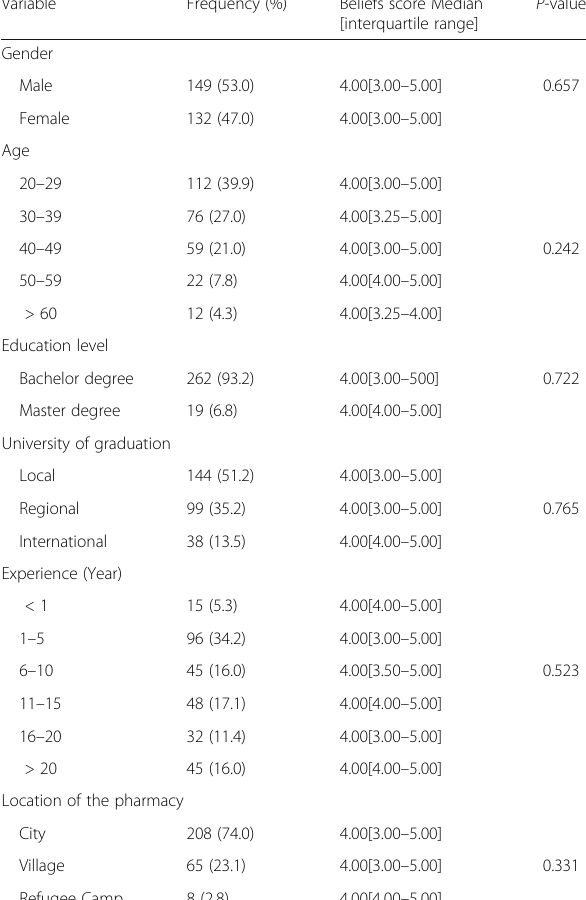
Table 3 Association between sociodemographic and practice variables of the participants and median belief score